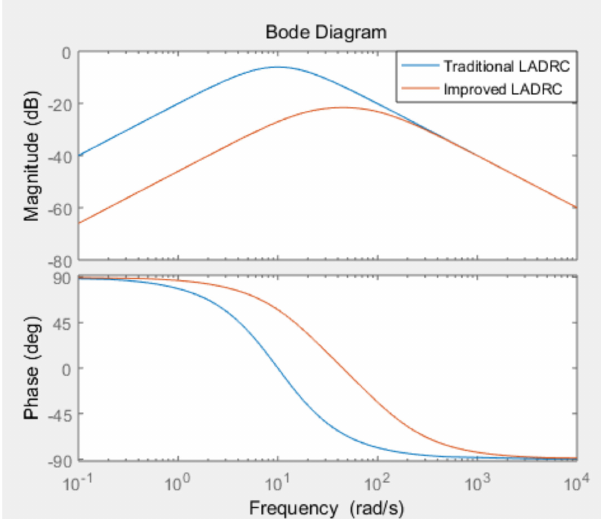
Figure 9. Comparative analysis of bode diagram of input disturbance.